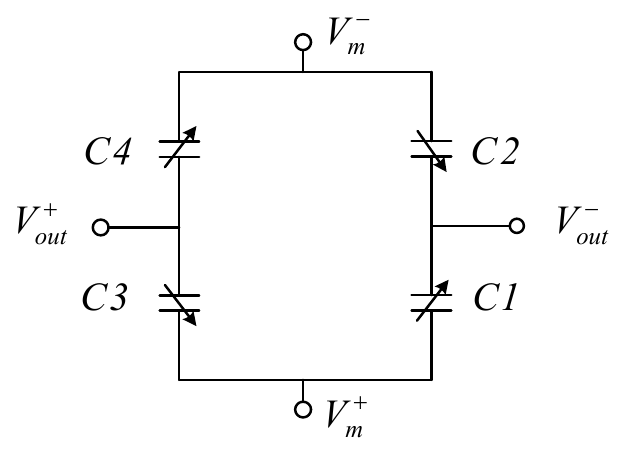
Figure 5. Simplified equivalent circuit of the